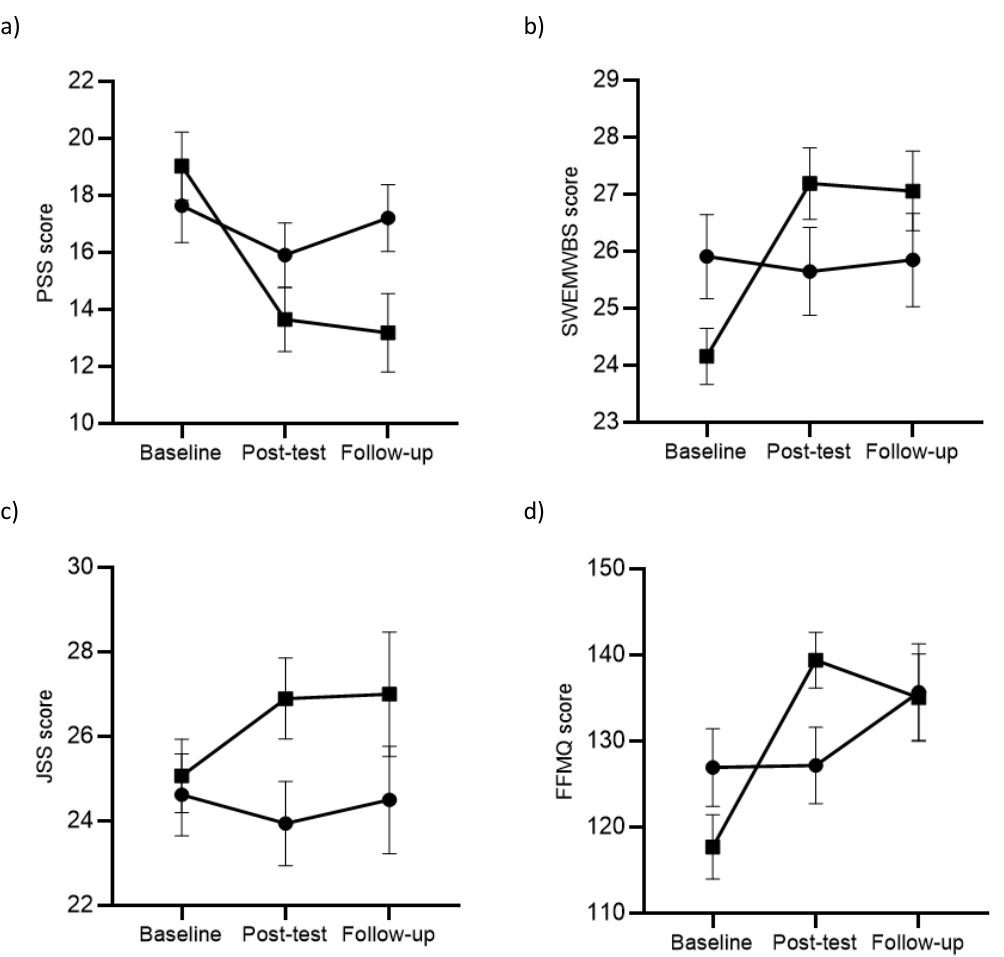
Figure 2. Graphical representation of WA-MBP-LS and control groups on outcomes over time. Note : WA-MBP-LS: Workplace-adapted mindfulness-based programme for the logistics sector. ( a ) PSS: Perceived Stress Scale. ( b ) SWEMWBS: Warwick-Edinburgh Mental Wellbeing Scale. ( c ) JSS: Job Satisfaction Scale. ( d ) FFMQ: Five Facet Mindfulness Questionnaire. ■ WA-MBP-LS group. ● Control group.